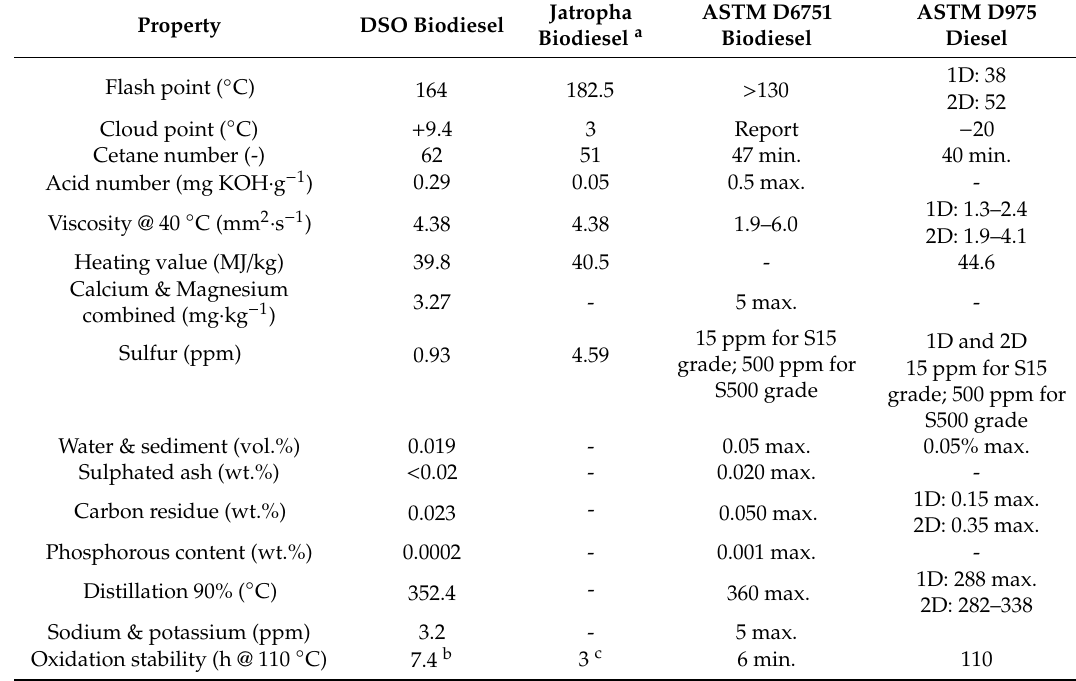
Table 2. DSO biodiesel specifications compared with Jatropha